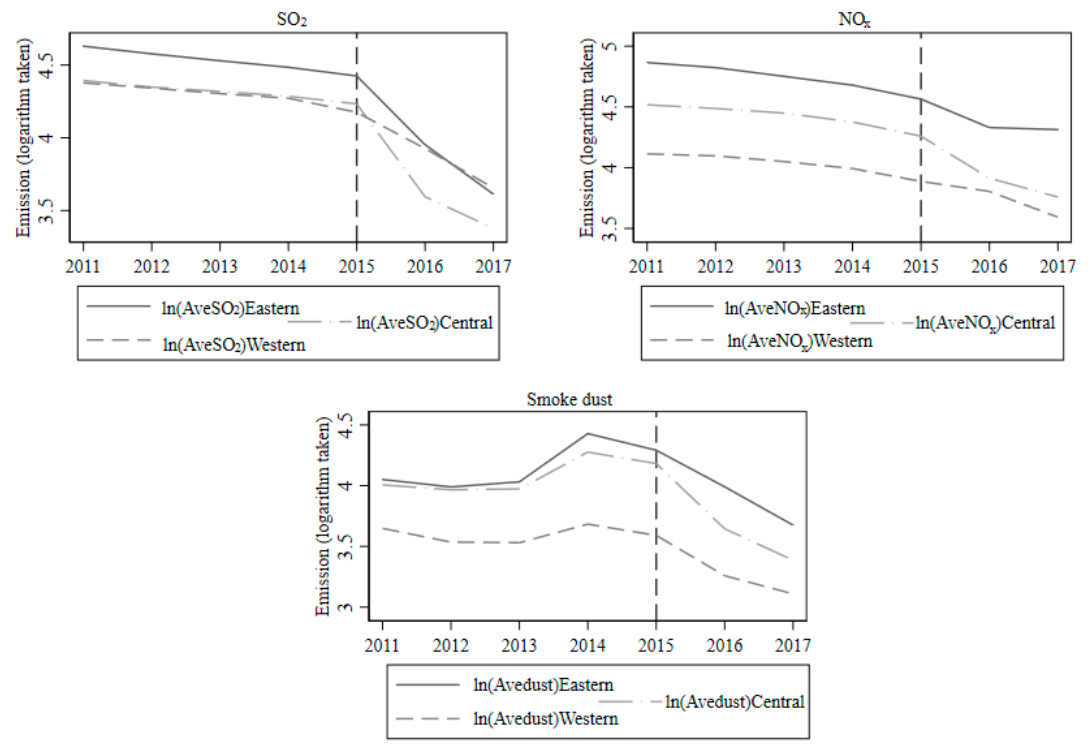
Figure 8. Parallel trend test for the treated and control groups.